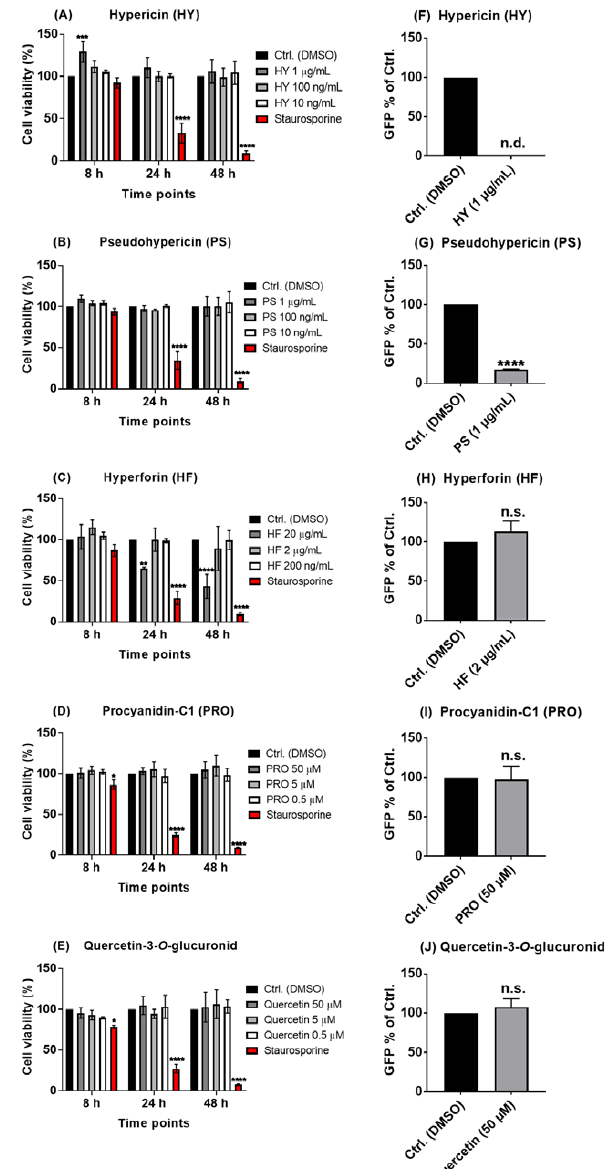
Figure 2. Hypericin and pseudohypericin are key components in the Hypericum perforatum (HP1) extract that are antivirally effective against the pseudo-typed VSV virus. ( A – E ) Vero cells were seeded overnight, and the next day, different concentrations of hypericin (HY), pseudohypericin (PS), hyperforin (HF), procyanidin-C1 (PRO), and quercetin-3- O -glucuronid (ingredients of HP1 extract) were applied onto the cells for indicated time points, as solvent-treated cells (DMSO) served as control. In addition, Staurosporine-treated cells served as positive control. After the incubations, the MTT assay-based cytotoxicity was measured, cell viability as % of solvent control is shown (mean and s.d), and two-way ANOVA with Dunnett’s Multiple comparisons was done by comparing each value with the solvent control at each time point. ( F – J ) Vero cells were seeded overnight, and on the next day, cells and the VSV-pseudo-typed virus were incubated with the indicated substances or solvent control (DMSO) for 1 h prior to infection, at 37 ◦ C or room temperature, respectively. After the pre-incubation, infection was performed with a MOI of 0.01 for 1 h, and cells were finally washed and incubated without further treatments. GFP-positive cells as % of solvent control are shown (mean and s.d.), and Student’s t -test with Welch’s correction was applied (n.d. means non-detected, while n.s. means non-significant statistical difference). * for p ≤ 0.05, ** for p ≤ 0.01, *** for p ≤ 0.001, and **** for p ≤